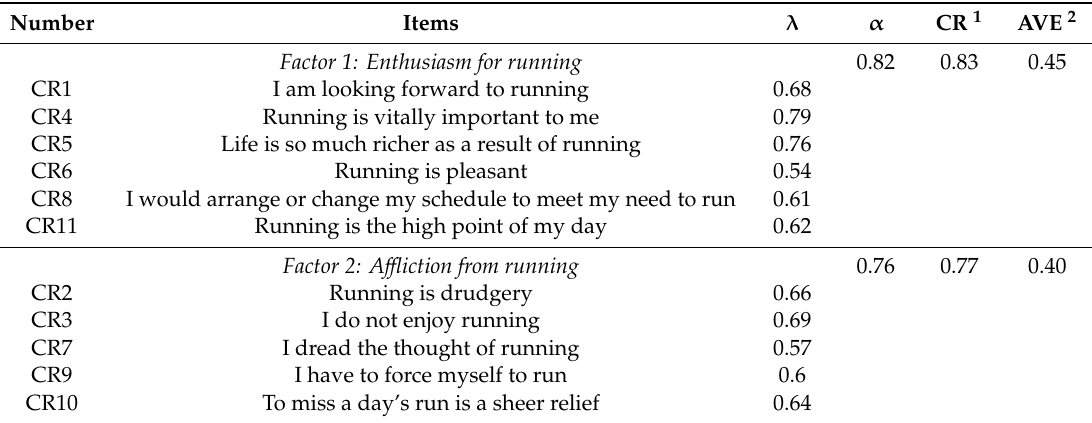
Table 4. Factorial loads, Cronbach’s alpha, composite reliability, and average variance extracted values from commitment to running scale